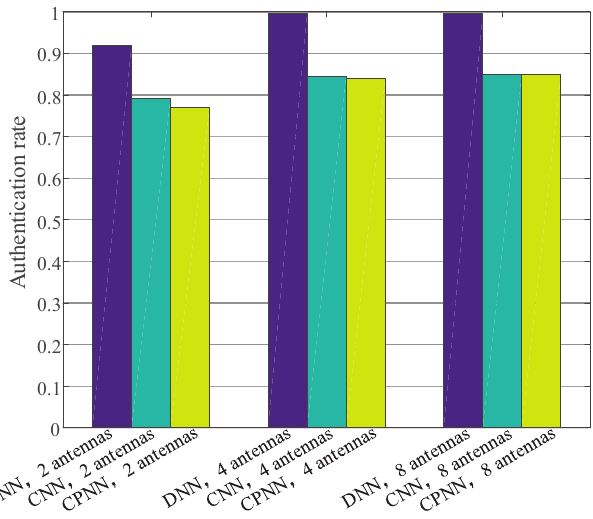
Figure 10. The authentication rate with